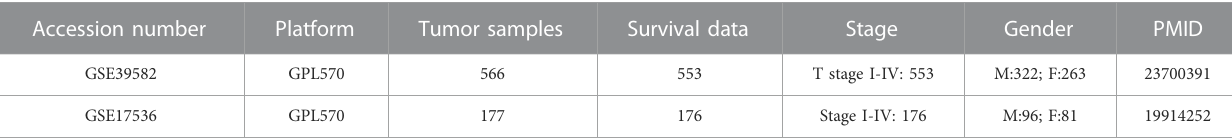
TABLE 2 Clinical information of CRC cohorts from GEO